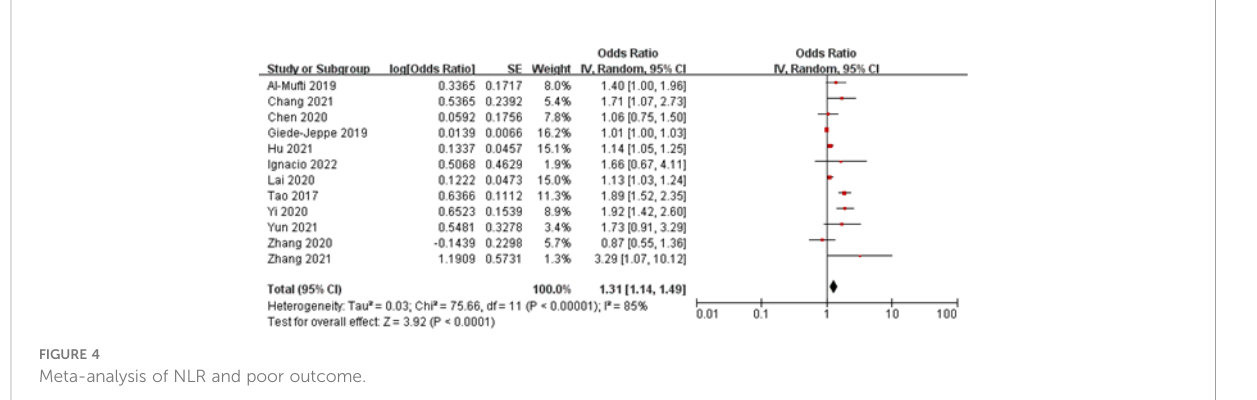
FIGURE 4 Meta-analysis of NLR and poor